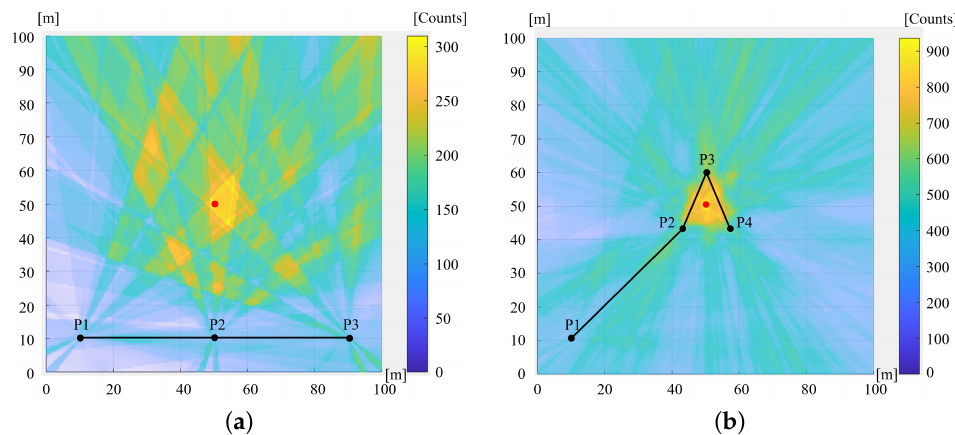
Figure 17. Comparison of two paths: (a) the robot did not approach the source and followed a certain path. (b) the robot approached the source and followed a path that surrounds the source. The red dot is a radiation source, and the black line depicts the moving trajectory of the robot. The paths were determined manually. The source with 5.7 MBq was placed, and the robot continued the measurement until the number of incident events exceeded 30 counts.